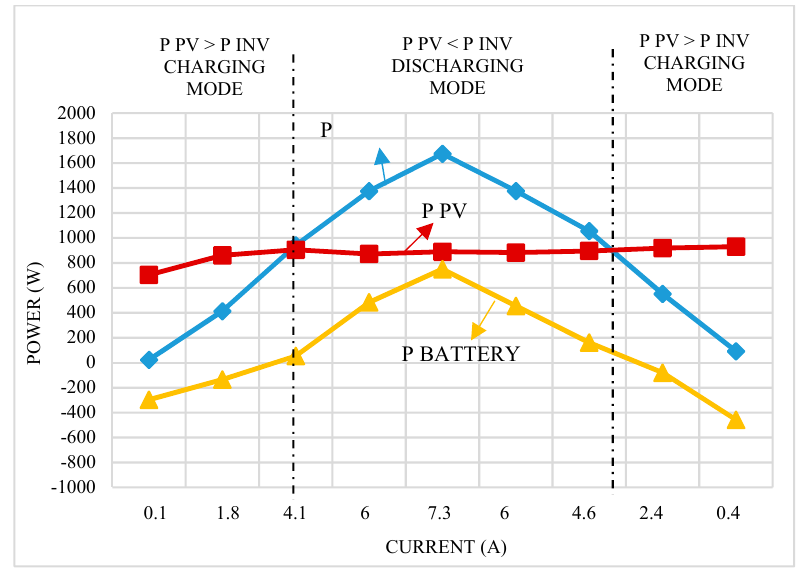
Figure 10. Battery charging and discharging process with varying load current.